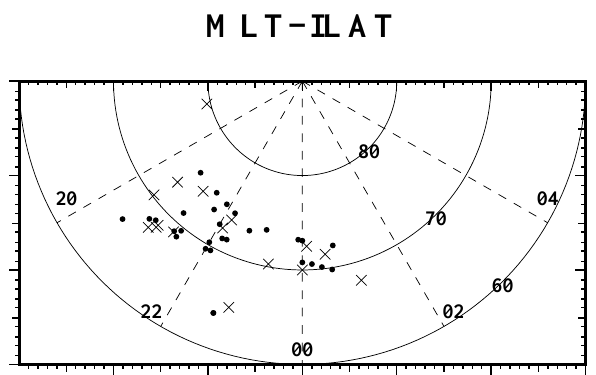
events are shown separately for both dot-AKR and SLFAKR.